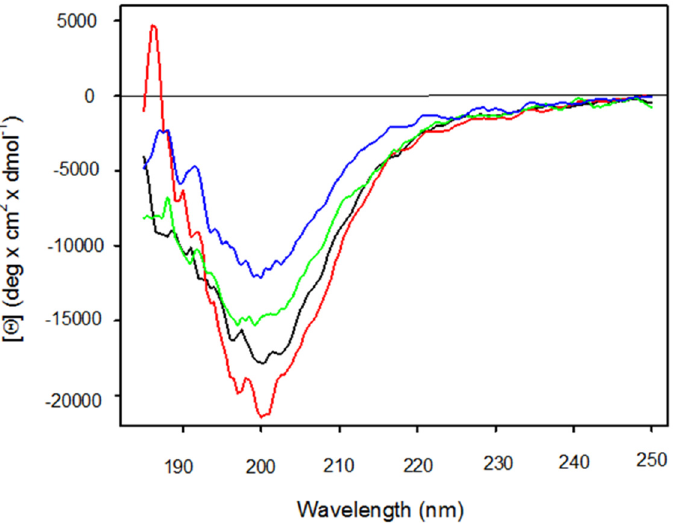
Figure 1. Far-UV CD spectra of peptides in water (Ma1 black line, Ma2 green line) and in 30% TFE (Ma1 red line, Ma2 blue line).